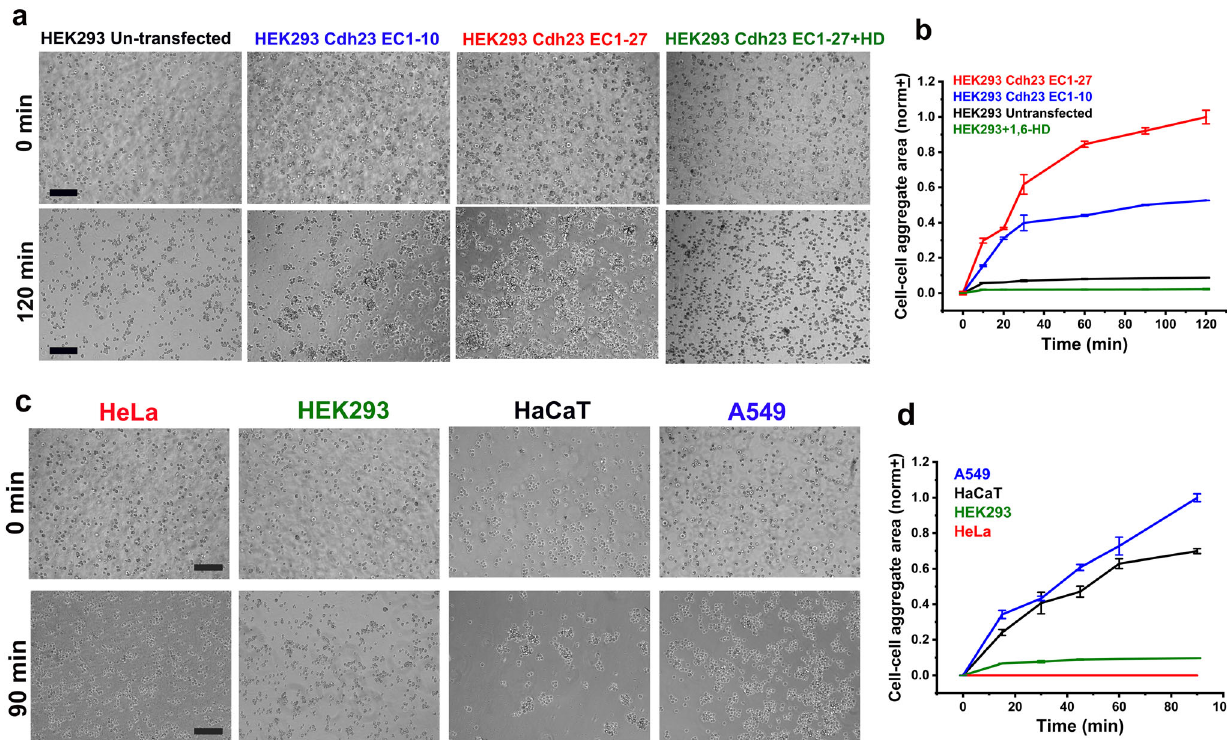
Fig. 3 Lateral clustering of Cdh23 on the membrane enhances the kinetics of cell-cell adhesion. a Time-stamp bright- fi eld images of cell-cell aggregations of HEK293 cells untransfected (1st column), transfected with Cdh23 EC1-10 (2nd column), Cdh23 EC1-27 (3rd column), and Cdh23 EC1-27 along with the treatment with 1,6-HD (4th column). Scale bar: 50 µ m. b The time-dependent growth of the cell-cell aggregation area of HEK293 cells exogenously expressing Cdh23 EC1-27 (red), Cdh23 EC1-27 and treated with 1,6-HD (olive), Cdh23 EC1-10 (blue), and untransfected cells (black). The error bars represent the standard error of the mean (SEM) with N = 15 aggregates. All the individual data points are shown in the scattered plots in the supplementary fi le. c Time-stamp bright- fi eld images of cell-aggregates of HeLa, HEK293, HaCaT, and A549 cells differentially expressing endogenous Cdh23. Scale bar: 50 µ m. d Growth of cell-cell aggregation area (in µ m 2 ) with time for HeLa (red), HEK293 (Olive), HaCaT (black), and A549 (blue) cell lines. Error bars represent the standard error of the mean (SEM) for N = 15 aggregates. All the individual data points are shown in the scattered plots in the supplementary fi